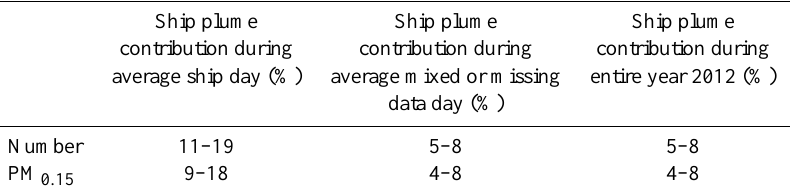
Table 4. Ship plume contribution to number and volume of particles at Høvsøre during a ship day, a mixed or missing data day and for the entire year